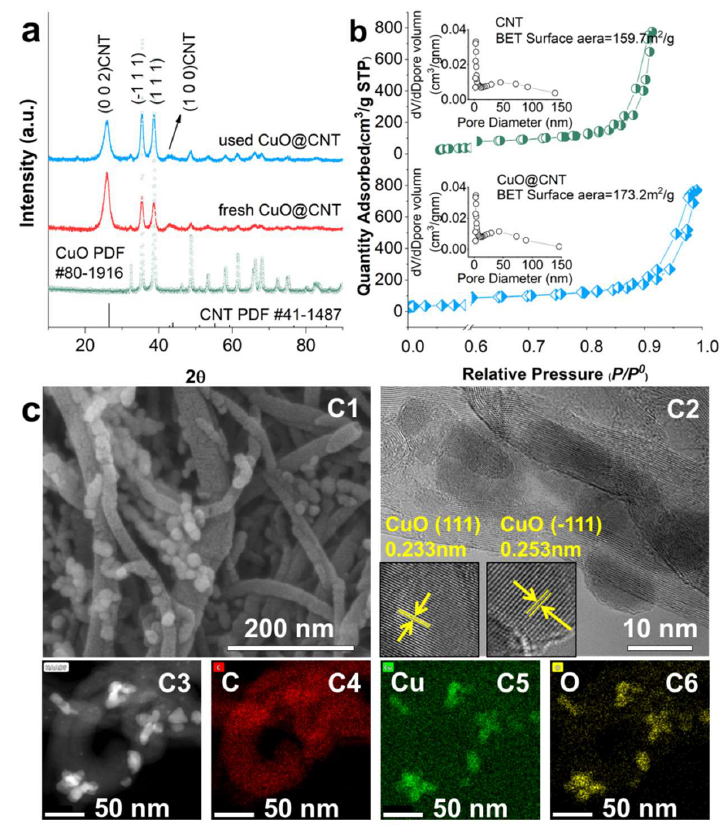
Figure 1. ( a ) XRD patterns of CuO and CuO@CNT; ( b ) BET measurements for CNT and CuO@CNT; ( c1 ) SEM images; ( c2 ) HRTEM images; ( c3 – c6 ) elemental mapping data of CuO@CNT.